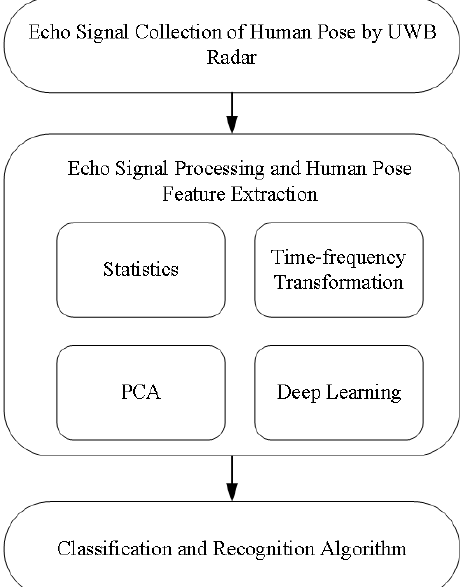
Figure 1. Human pose recognition model for the UWB